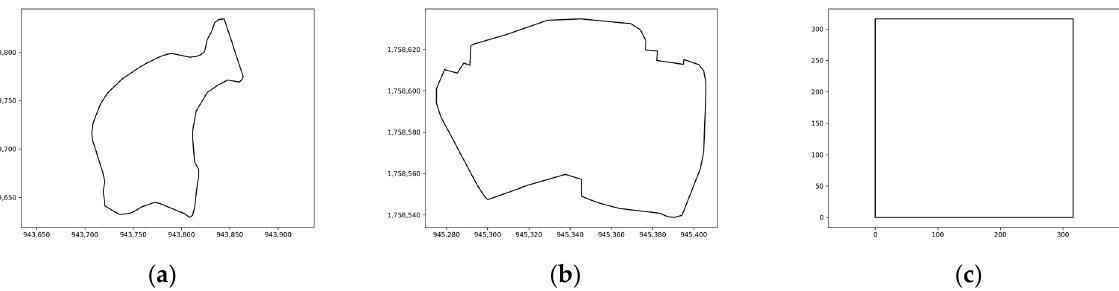
Figure 16. (a) Complex field: Case A; (b) Complex field: Case B; (c) Simple field: Case C (square). Figure 15. ( a ) Complex field: Case A; ( b ) Complex field: Case B; ( c ) Simple field: Case C (square).